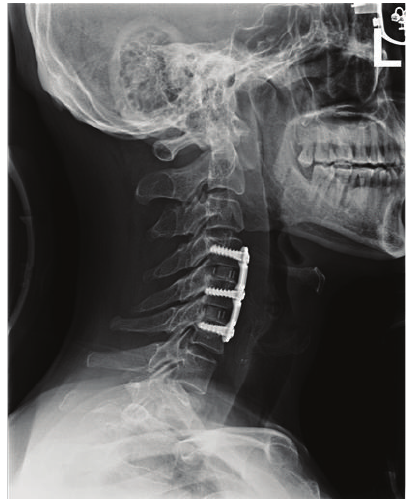
Figure 5: PEEK cages in a 65-year-old male postoperatively.